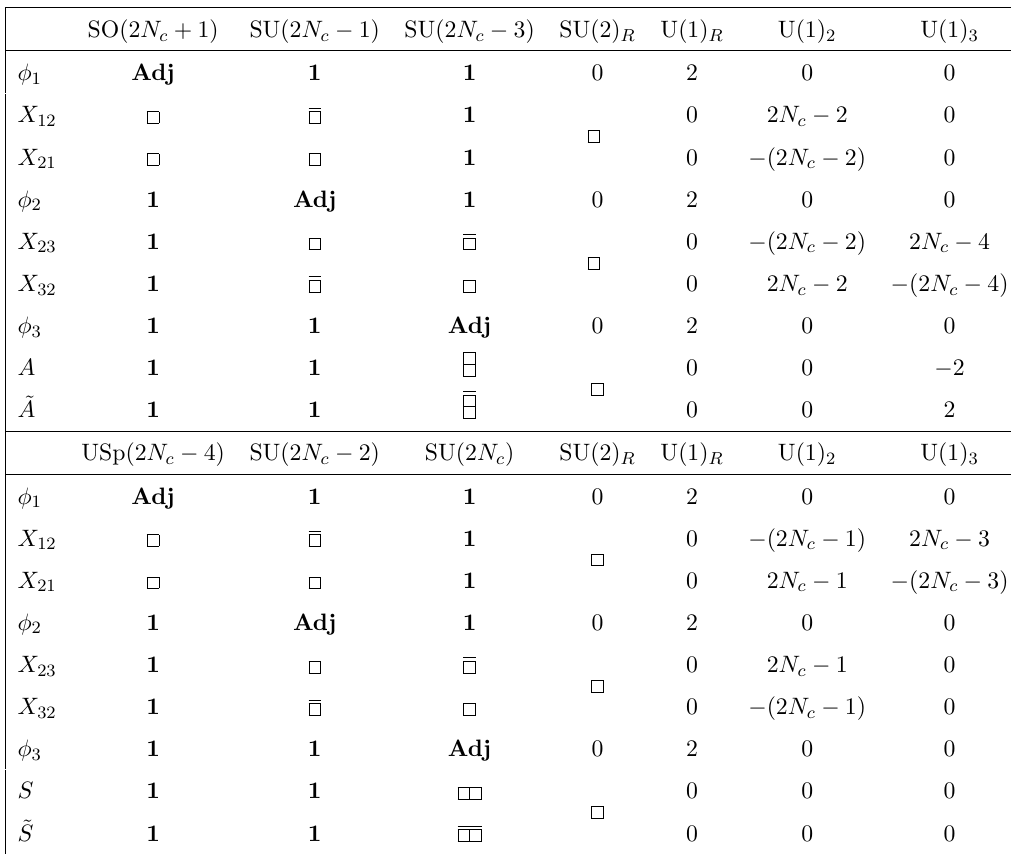
Table 6 . Matter content and charges of N = 2 S-dual quivers with n g = 2